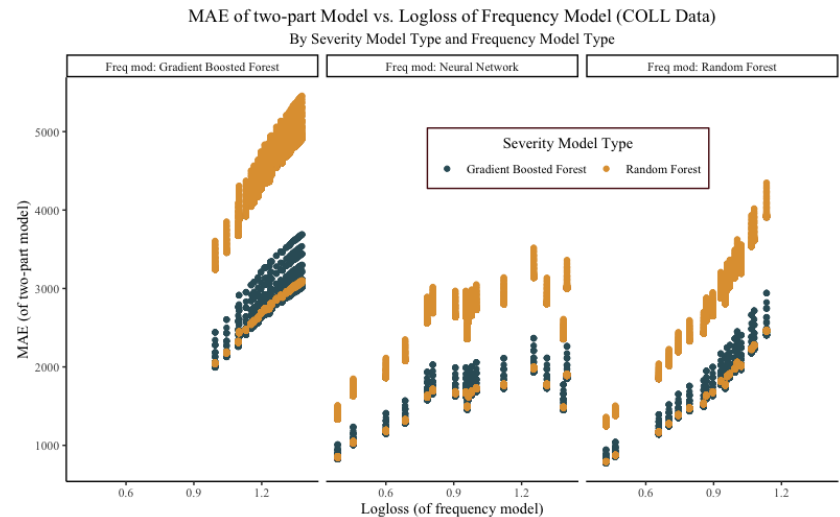
Figure 22. Comparison of the logloss of the frequency model part to the MAE of the overall two-part model for the COLL data. MAE of the entire two-part model is shown on the y -axis, while logloss of the frequency model is shown on the x -axis in order to illustrate how the logloss can affect the overall performance of the two-part model. Different types of frequency models are shown in each pane, while severity model types are shown by different colored